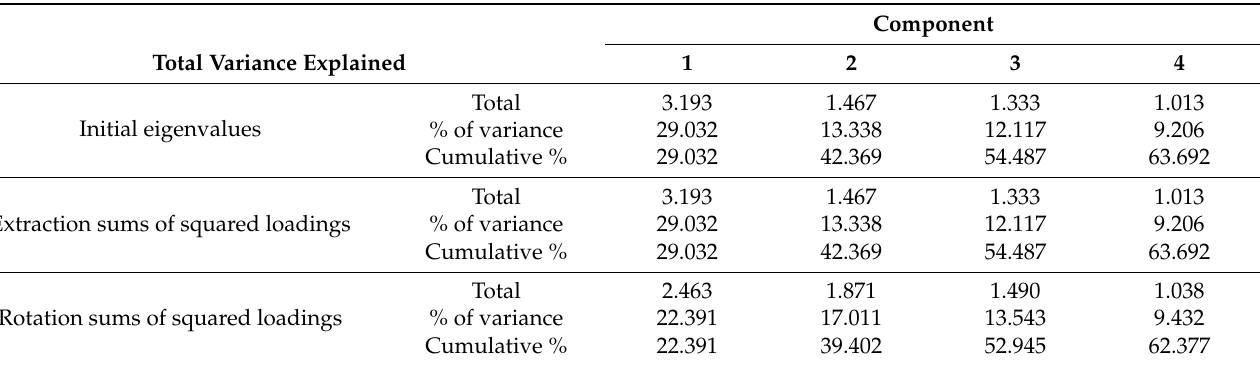
Table 5. Principal components analysis: reduction of the dimensionality of the data to a small number of components.